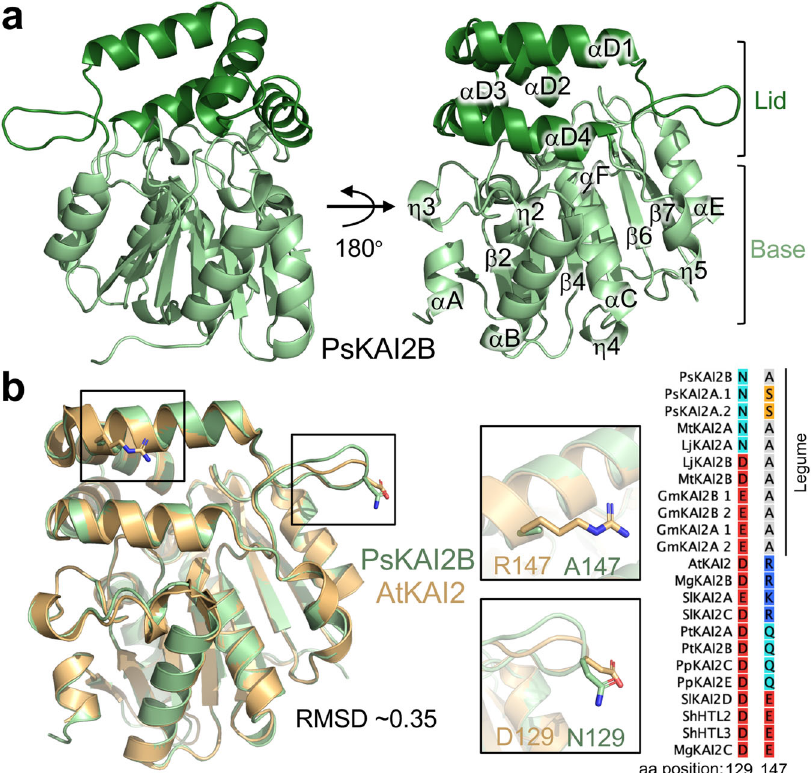
Fig. 6 The crystal structure of legume KAI2. a Overview of PsKAI2B structure. Lid and base domains are colored in forest and light green respectively with secondary structure elements labeled. b Structural alignment of PsKAI2B and AtKAI2 (PDB ID: 4HTA) shown in light green and wheat colors respectively. Root-mean-square deviation (RMSD) value of the aligned structures is shown. The location and conservation of legume KAI2 unique residues, alanine in position 147 (A147) and asparagine N129, are highlighted on the structure shown as sticks as well as in reduced Multiple Sequence Alignment from Supplementary Fig.